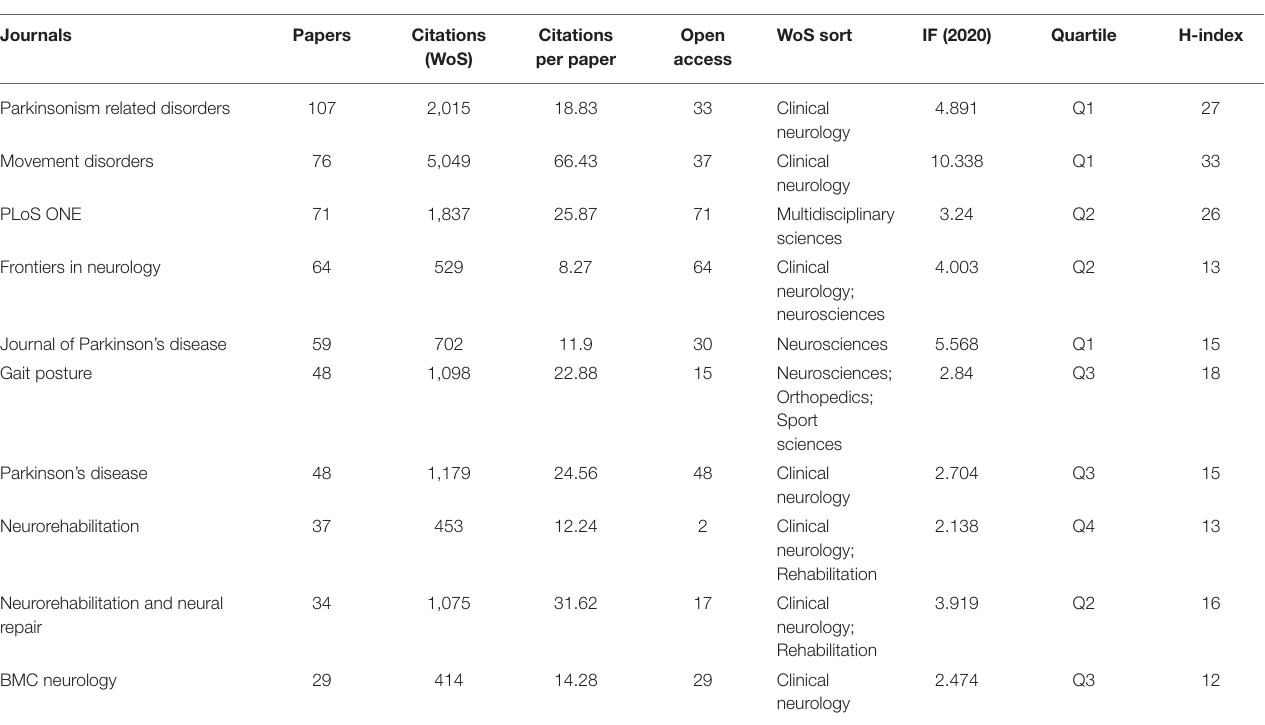
TABLE 2 | Top 10 journals in the field of exercise on